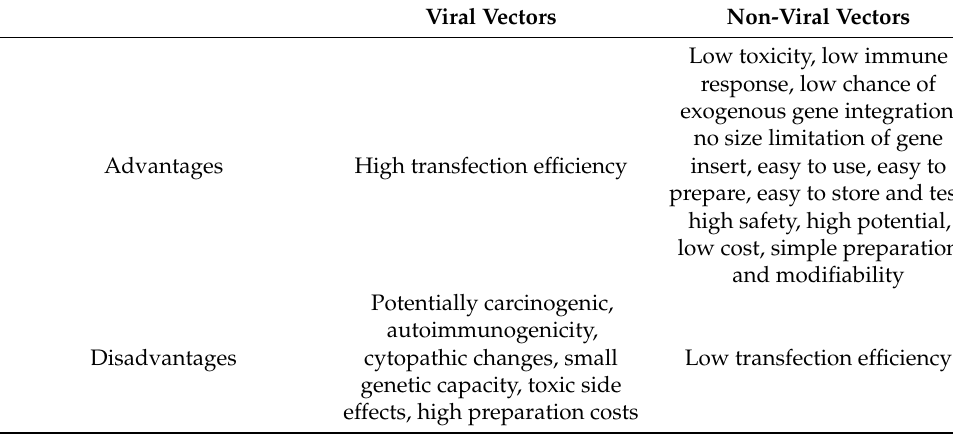
Table 2. Advantages and disadvantages of viral and non-viral